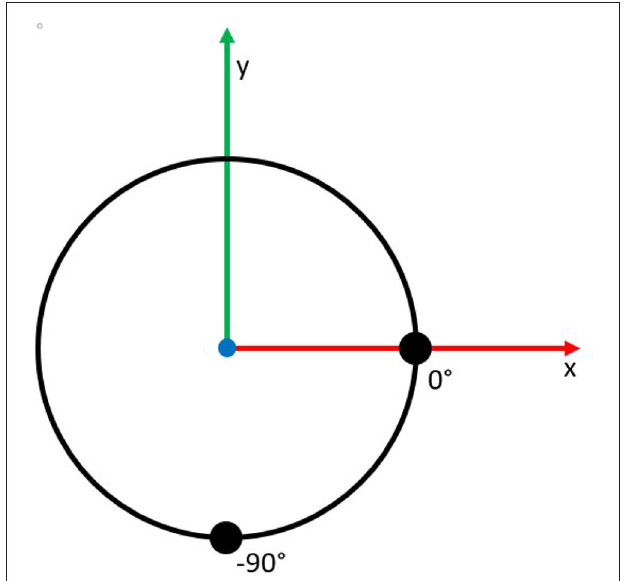
FIGURE 3 | A cross-sectional illustration of the sensor locations at 0 ◦ and − 90 ◦ on the circumference of the joint.